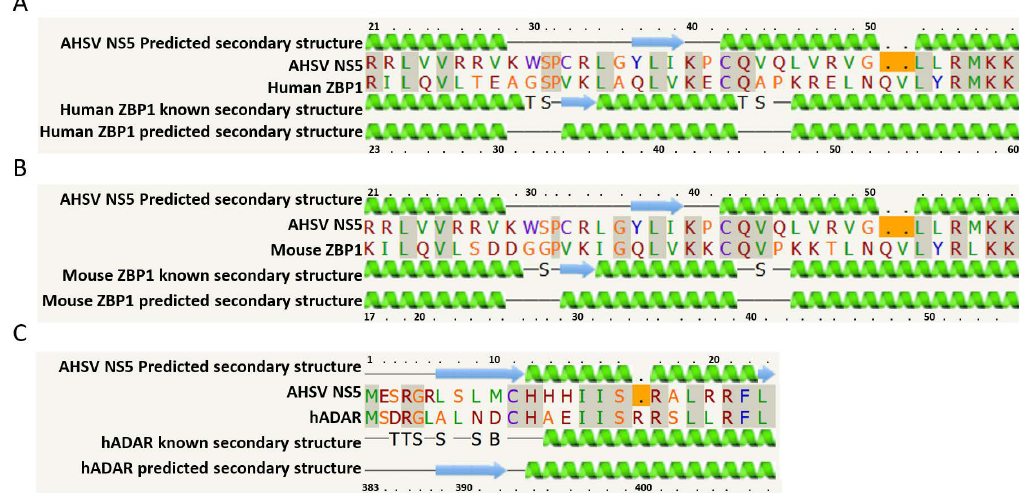
Figure 1. Secondary structure predictions for the amino acid sequence of AHSV NS5 (KP939687 (AHSV-4), KP939916.1 (AHSV-6), KT030659.1 (AHSV-8), and KP940226.1 (AHSV-9)). In the known structures of human ZBP1 ( A ), mouse ZBP1 ( B ), or hADAR ( C ), blue arrows indicate beta sheets and green coils indicate alpha helices; T is a hydrogen-bonded turn; B is a residue in an isolated β -bridge and S is a